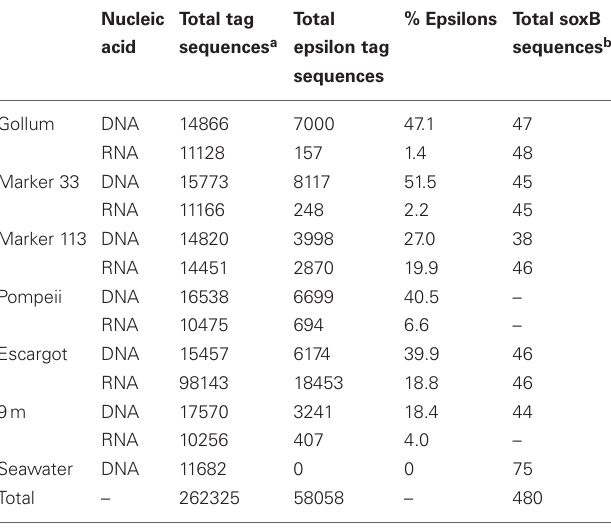
Table 3 | Sequencing statistics for 16S rRNA and soxB gene sequences.